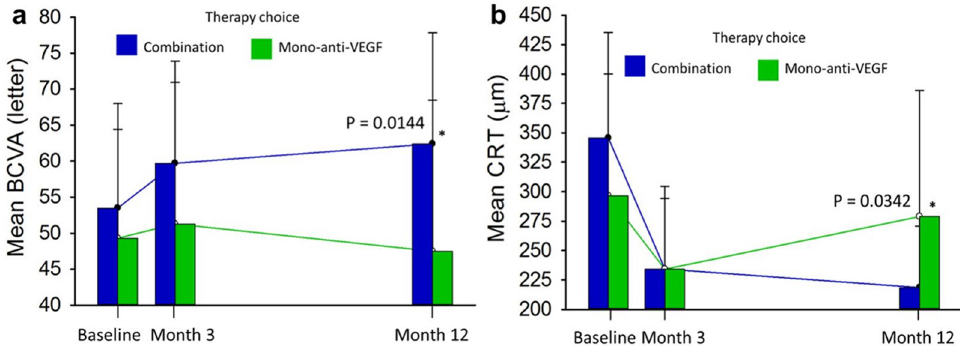
Figure 1. Visual outcomes by therapy choice during the 12-month treatment. ( a ) Mean BCVA. ( b ) Mean CRT. Blue line, combination therapy; green line, mono-anti-VEGF therapy. BCVA best-corrected visual acuity, CRT central retina thickness. Asterisks indicate significant differences.